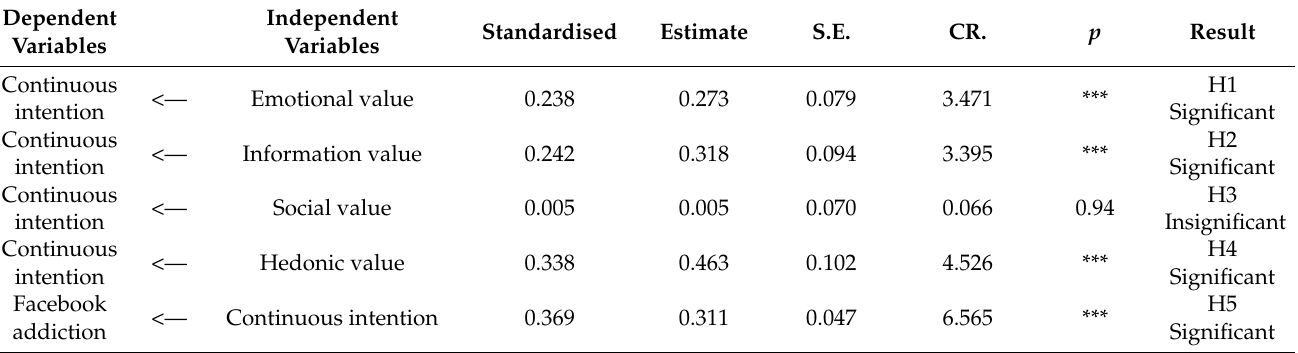
Table 8. Result for testing H1 to H5.